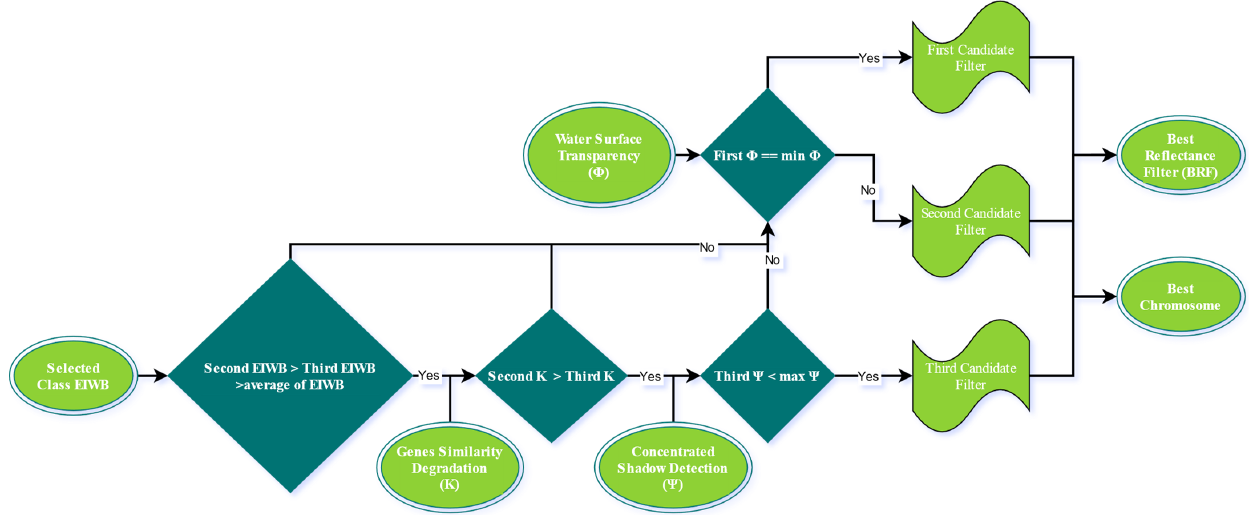
Figure 7. Processing chart of the best reflectance filter selection.